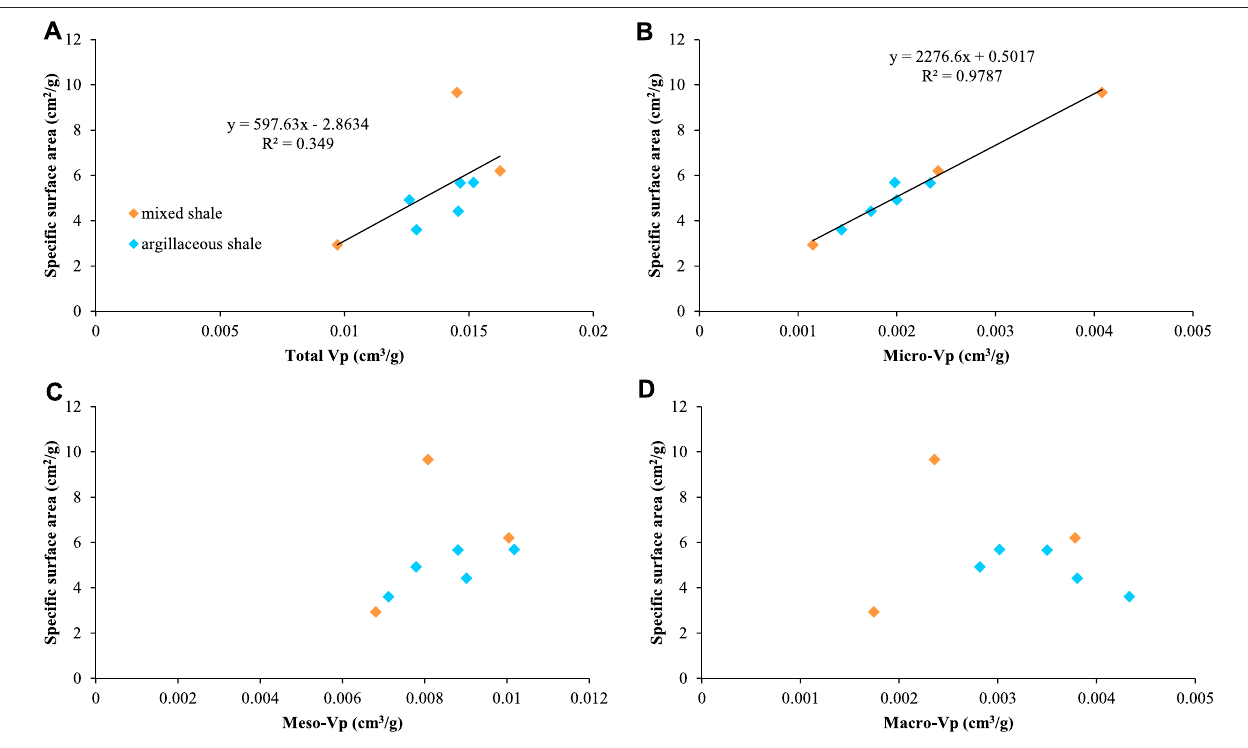
FIGURE8| Intersectiondiagramsofporevolumeandspeci fi csurfacearea. (A) totalV p andspeci fi csurfacearea; (B) micro-V p andspeci fi csurfacearea; (C) meso- V p and speci fi c surface area; (D) macro-V p and speci fi c surface area